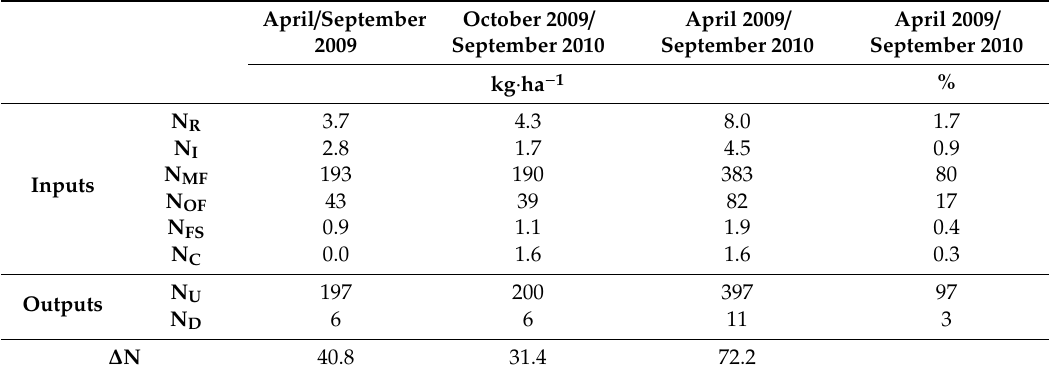
Table 4. Nitrogen loads. Total nitrogen input and output (in kg / ha) in the